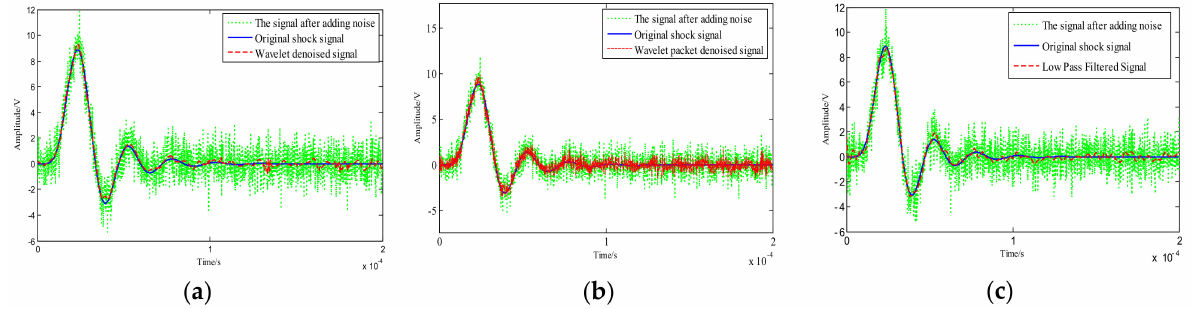
Figure 8. ( a ) Wavelet threshold denoising for the constructed signal; ( b ) wavelet packet threshold denoising for the constructed signal; ( c ) low-pass filtered for the constructed